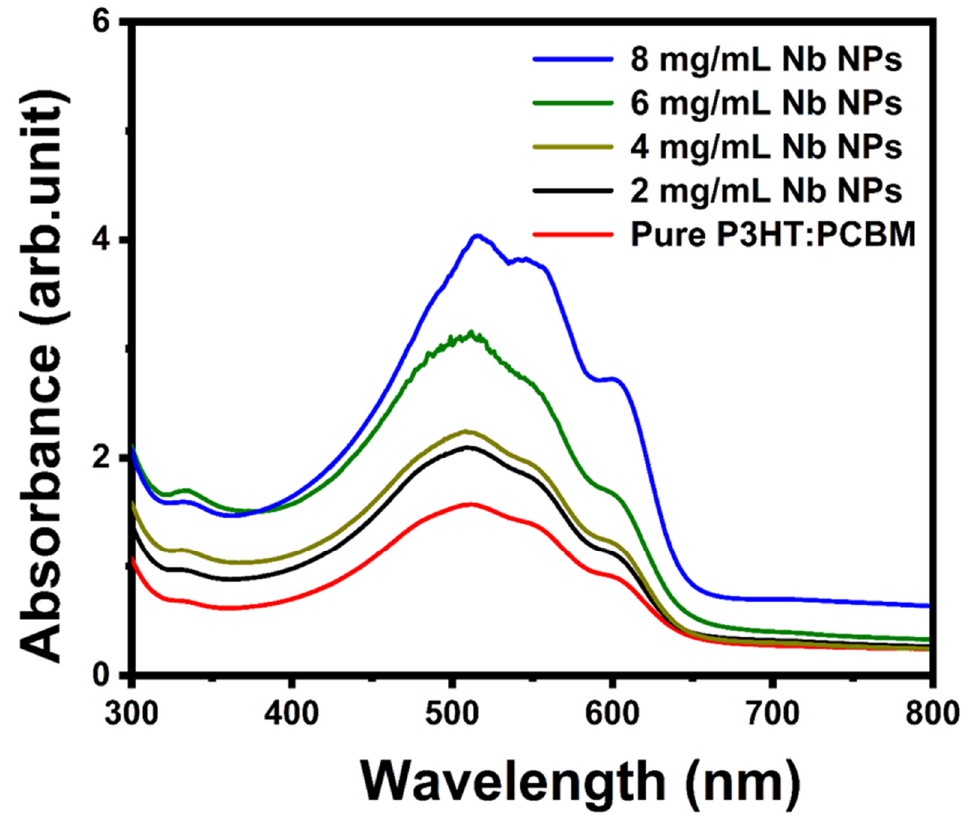
Figure 8. Optical absorption spectra of pure P3HT:PCBM and PCBM:P3HT thin films doped using different Nb concentrations.